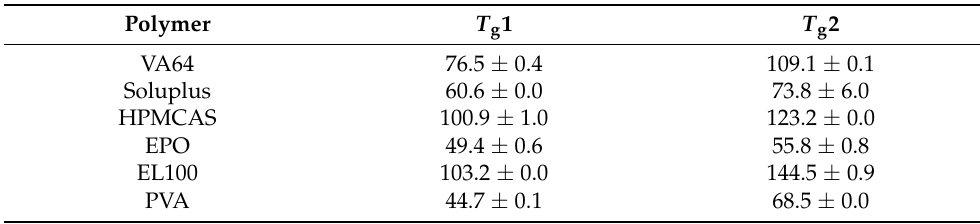
Table 2. Glass transition temperatures ( T g ) ( ◦ C) of the polymers.